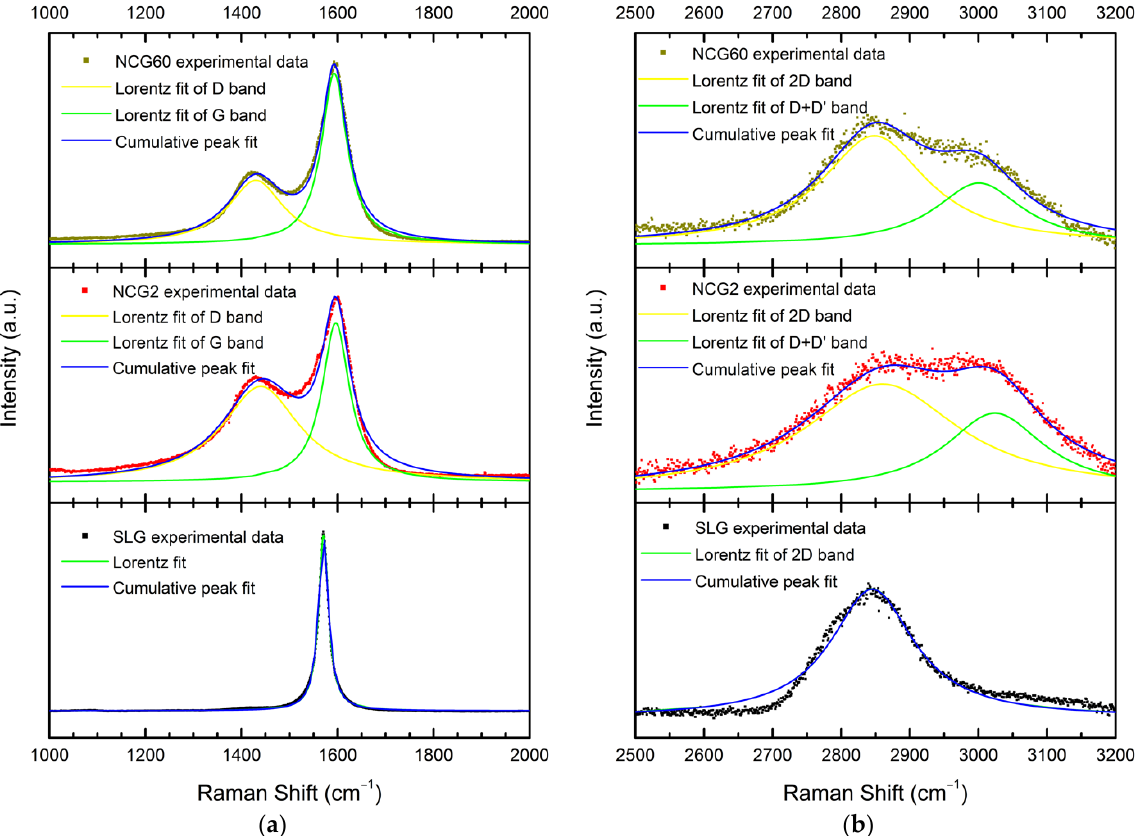
Figure 9. Raman spectra of commercial single-layer graphene (SLG), NCG2, and NCG60 acquired with a 325 nm He-Cd laser, showcasing the ( a ) D and G, and ( b ) 2D and D + D’ Raman bands fitted with Lorentzian peaks. Table 2. Raman spectra parameters: ω D , ω G , I D /I G , I 2D /I G and the calculated basal plane domain size.